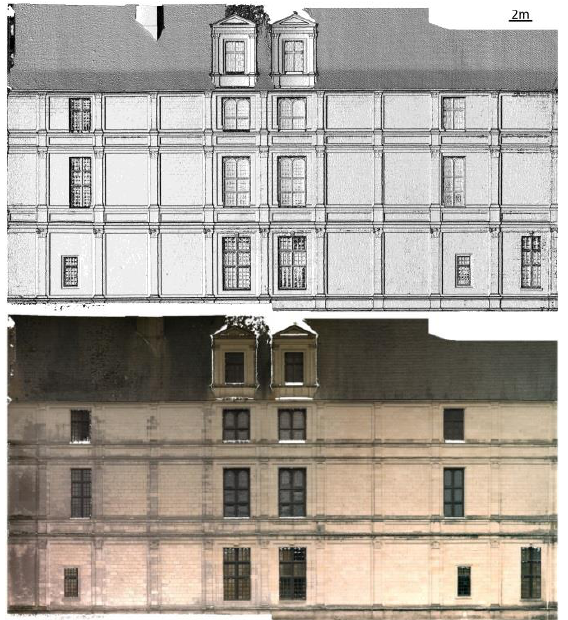
Figure 10: Shaded relief image and unwrapped orthoimage of Tour du Donjon (TO)